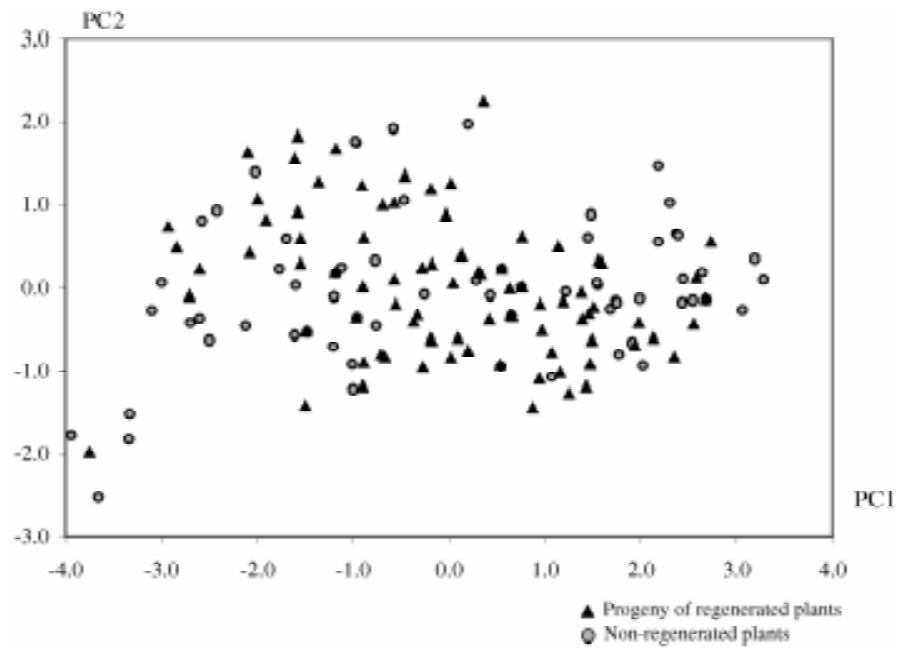
Figure 2 - Plot of the individuals on the basis of principal component 1 (PC1) and principal component 2